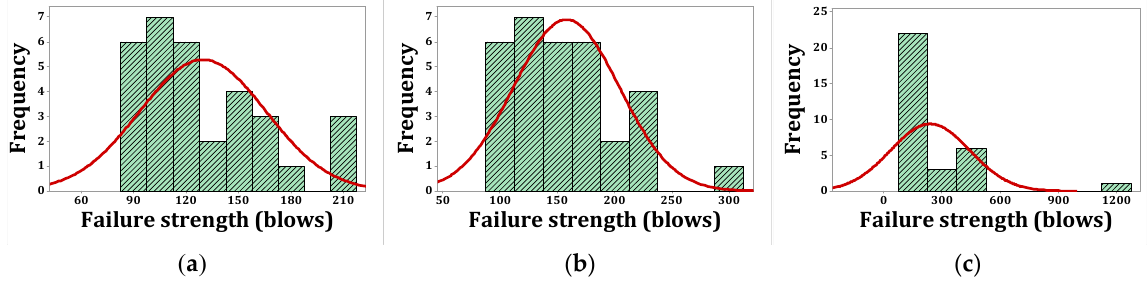
Figure 24. Distribution plots for failure strength (dry): ( a ) R, ( b ) F2, ( c ) F3.